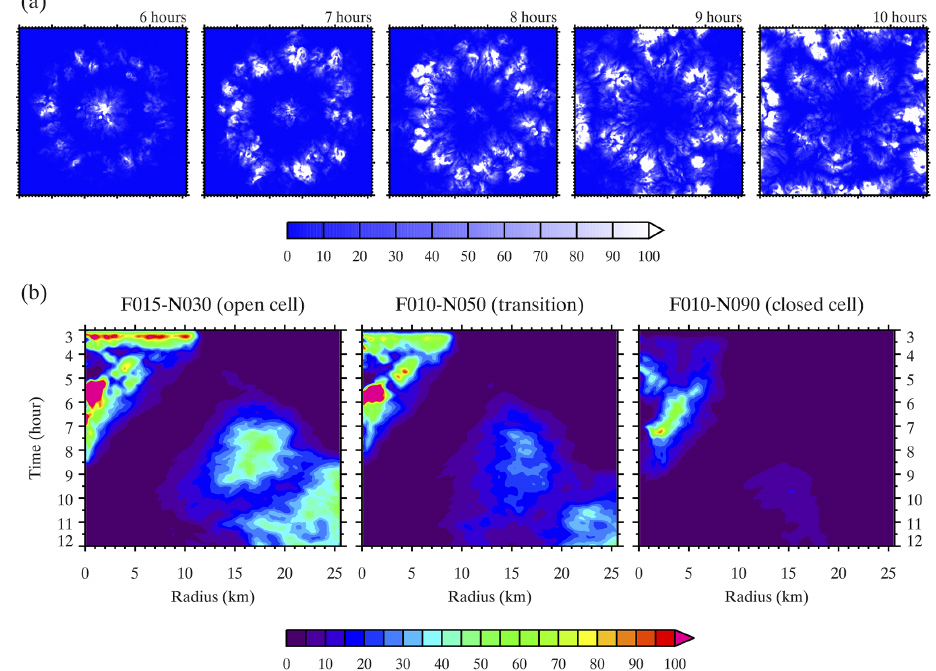
Figure 6. (a) Time evolution of RWP (gm − 2 ) between 6 and 10h for F015-N030. (b) Hovmöller diagram of the radially averaged RWP for three S2 cases. A radius of 0km represents the domain center.